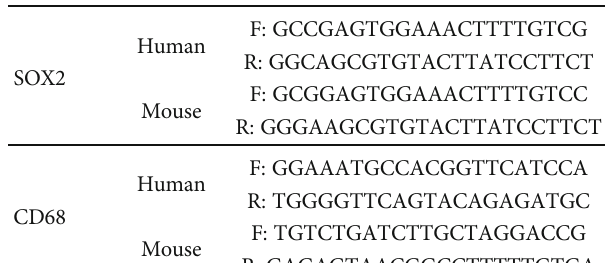
Table 1: Primer sequences. Table 1: